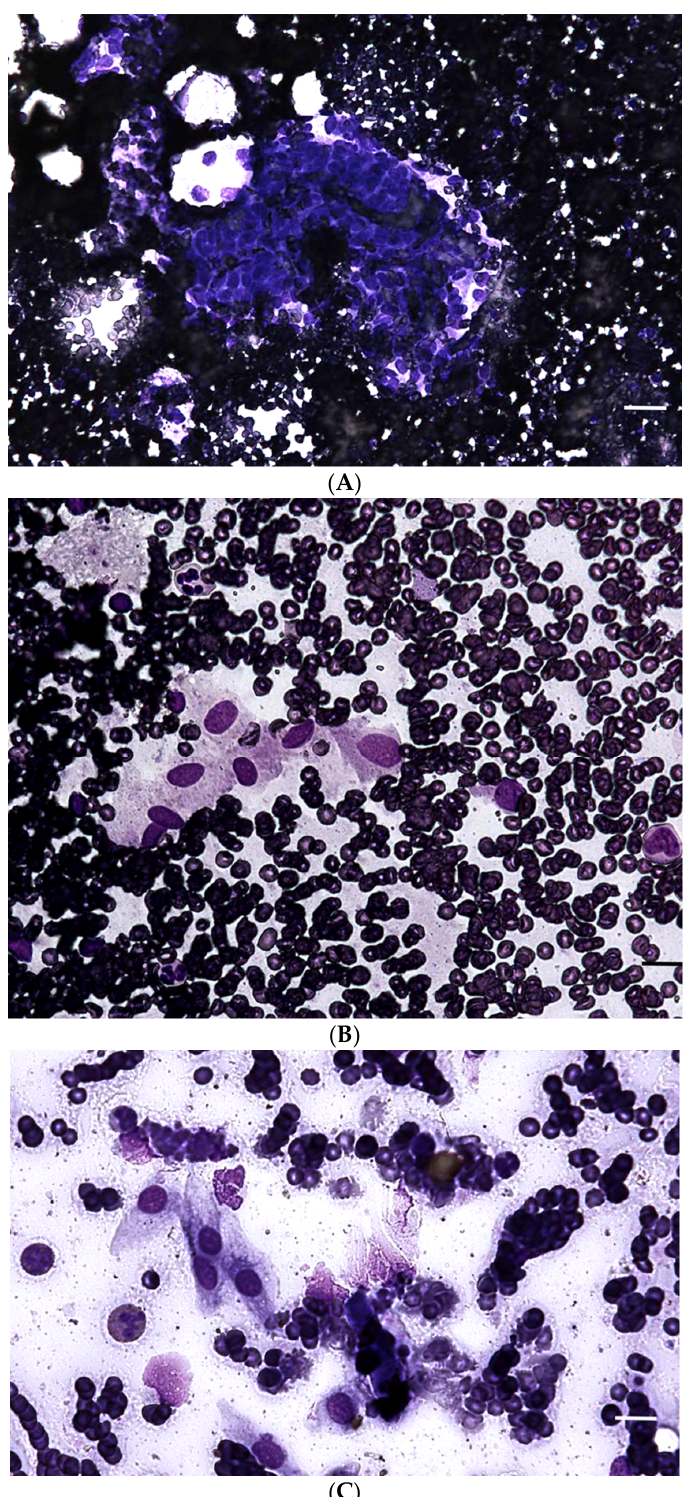
Figure 5. Intra-abdominal inflammatory myofibroblastic tumor, cat. May-Grünwald-Giemsa. Cytological specimen of the recurrence characterized by the presence of spindle to stellate cells visible as aggregates ( A ), size bar = 40 μm, magnification 10×) or single cells ( B ), size bar= 20 μm, magnification 20×). The background is highly hematic. ( C ). First cytology shows the presence of the same population. Size bar= 20 μm, magnification 20×.